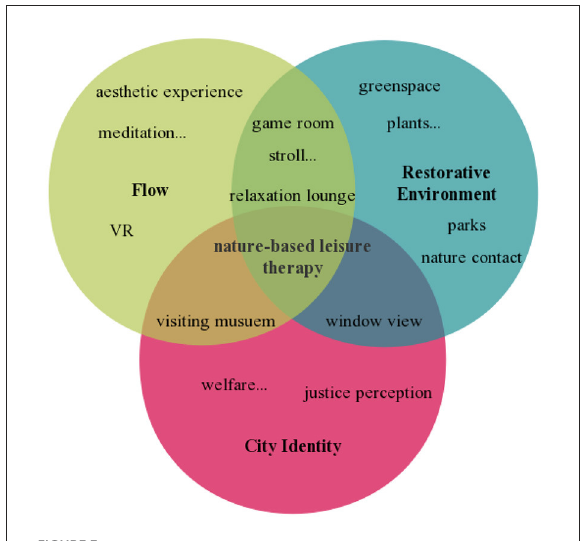
FIGURE3 The proposed intervention model synthesizing flow, city identity, and restorative